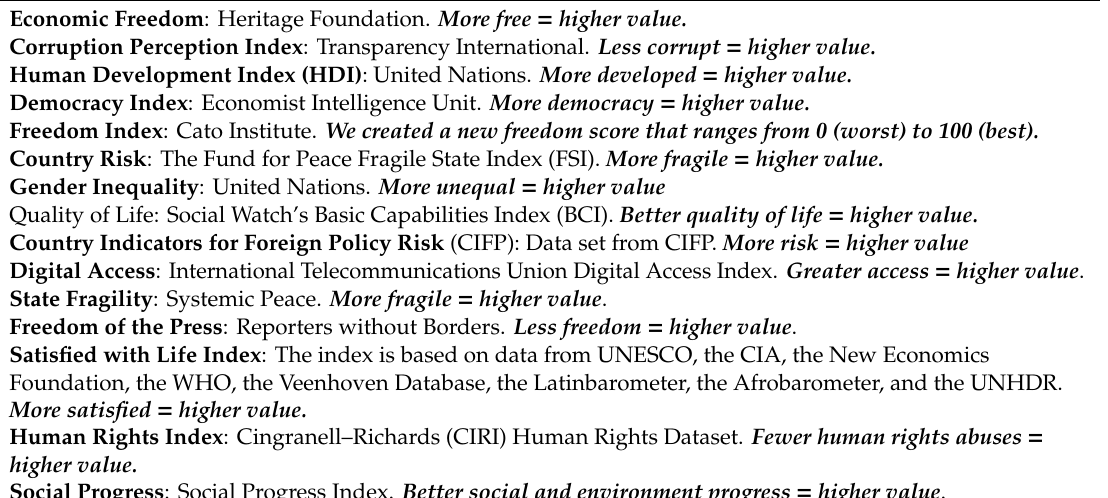
Table 1. Description of indices.